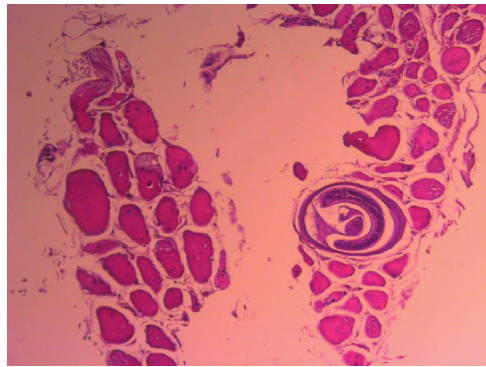
Figure 1: Cysts of Trichinella spiralis (low-power view).